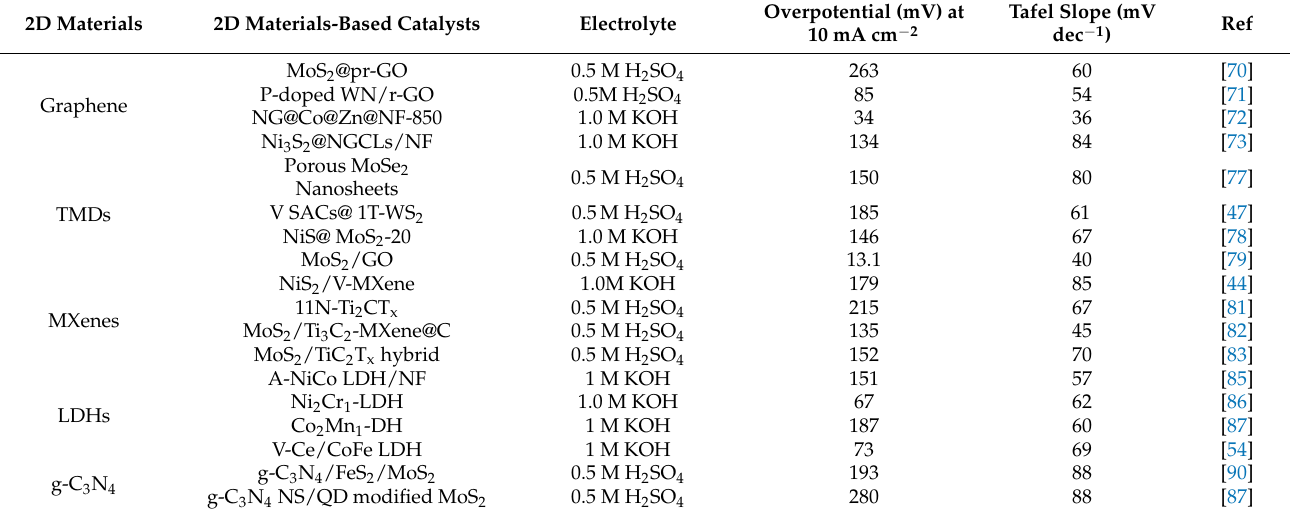
Table 1. The HER performance of 2D-layered non-precious-based electrocatalysts in acidic and alkaline